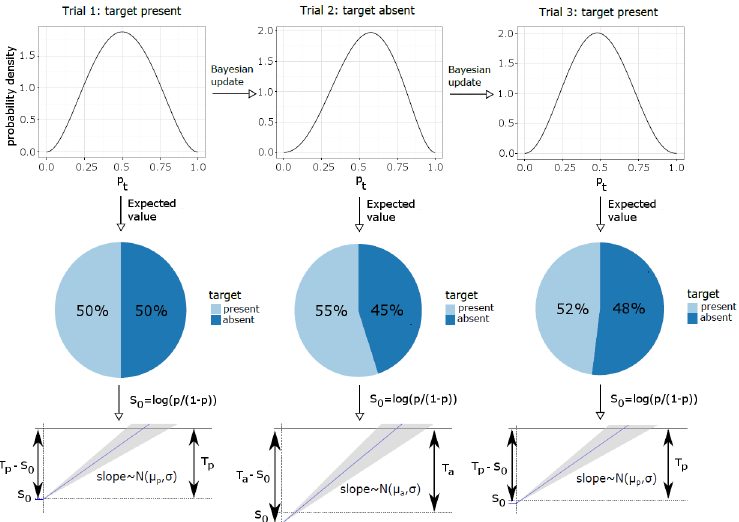
Fig 7. Schematic illustration of prior updating and the resulting changes of the starting point. The top panels show the hyperprior, i.e., the probability distribution on the frequency of target present trials (p), and how it changes over three subsequent trials. The middle panels show the current best estimate of the frequency distribution over target- present and -absent trials (i.e., p and 1 − p). The best estimate of p is defined as the expected value of the hyperprior. The bottom panels show a sketch of the evidence accumulation process where the starting point is set as the log prior odds for the two response options (target- present vs. -absent), computed based on the current best estimate of p. T p and T a are the decision thresholds for target-present and -absent responses, respectively, and μ p and μ a are the respective drift rates. The sketch of the evidence accumulation process is based on the LATER model (rather than the DDM) and therefore shown with a single boundary (that associated with the correct response). Note that the boundary depicted for trial 2 (target absent) is not the same as those for (target-present trials) trials 1 and 3. In the